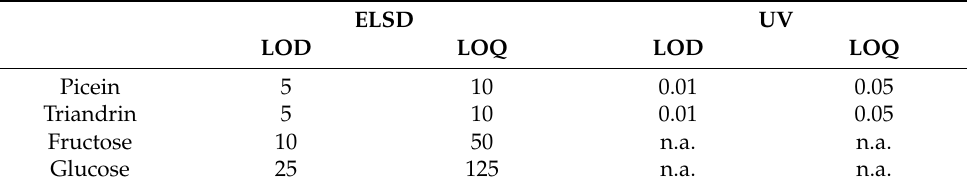
Figure 3. Chromatogram (UV at 260 nm and ELSD signals) of willow bark extract. Eluent used was A = 30% MeOH in water, B = ACN (A/B = 20/80). A = 30% MeOH in water, B = ACN (A/B = 20/80). Table 1. Limit of detection (LOD) and limit of quantification (LOQ) presented as mg/l for main compounds in willow bark extract.